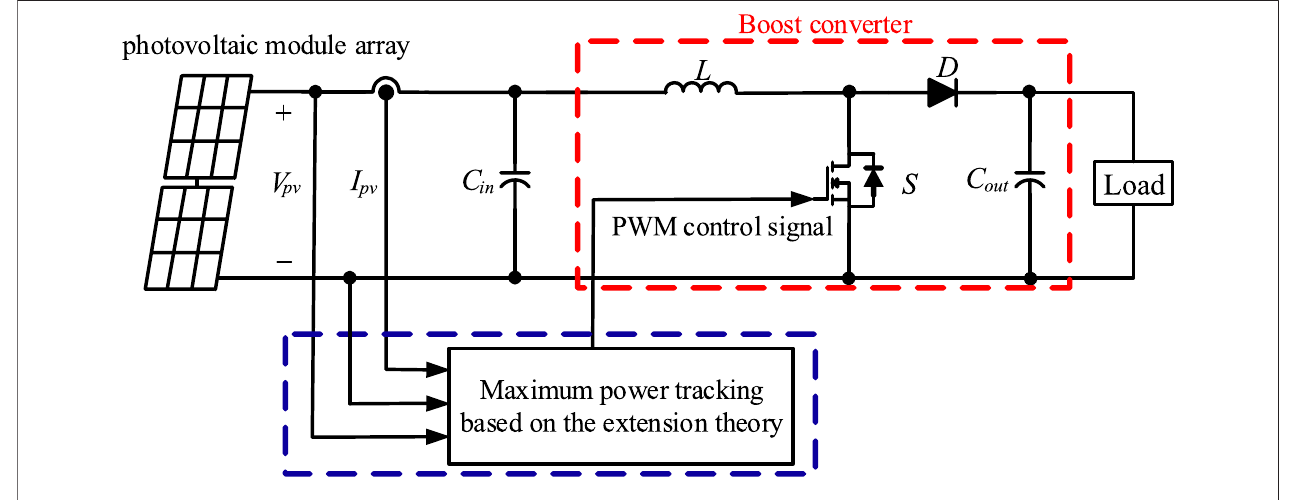
FIGURE 2 | Maximum power tracking system architecture based on the extension